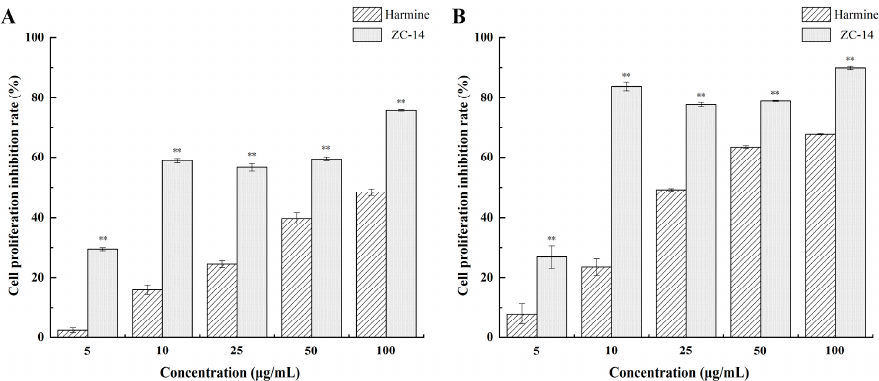
Figure 2. MTT assay of harmine and ZC-14 cytotoxicity on Sf9 cells for 24 h ( A ) and 48 h ( B ). All data